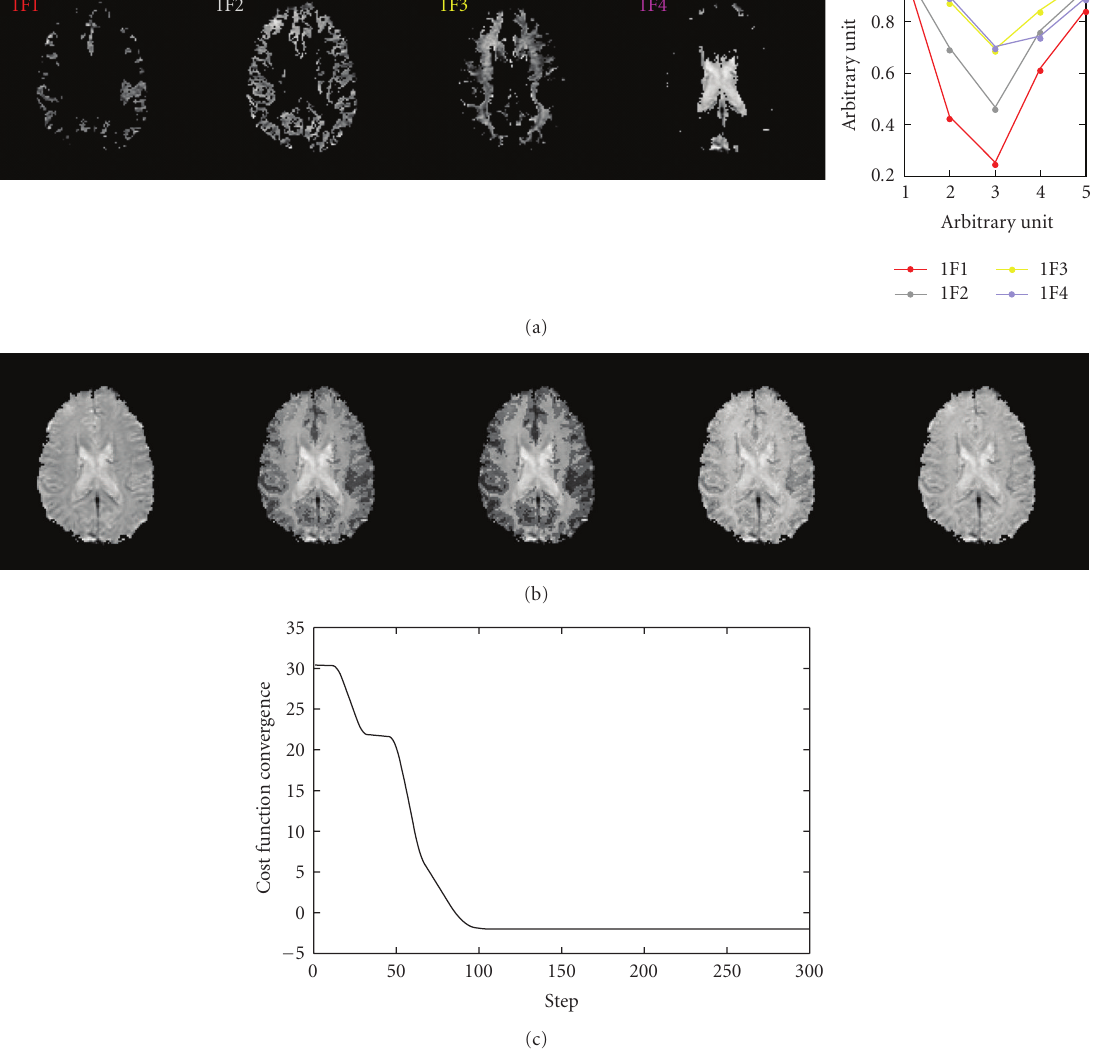
Figure 2: Computer simulation for the evaluation of the IFA method. (a): The four hypothetical IF images and columns of the hypothetical mixing matrix (the right most plot). (b): The simulated images. (c): The convergence of the IFA